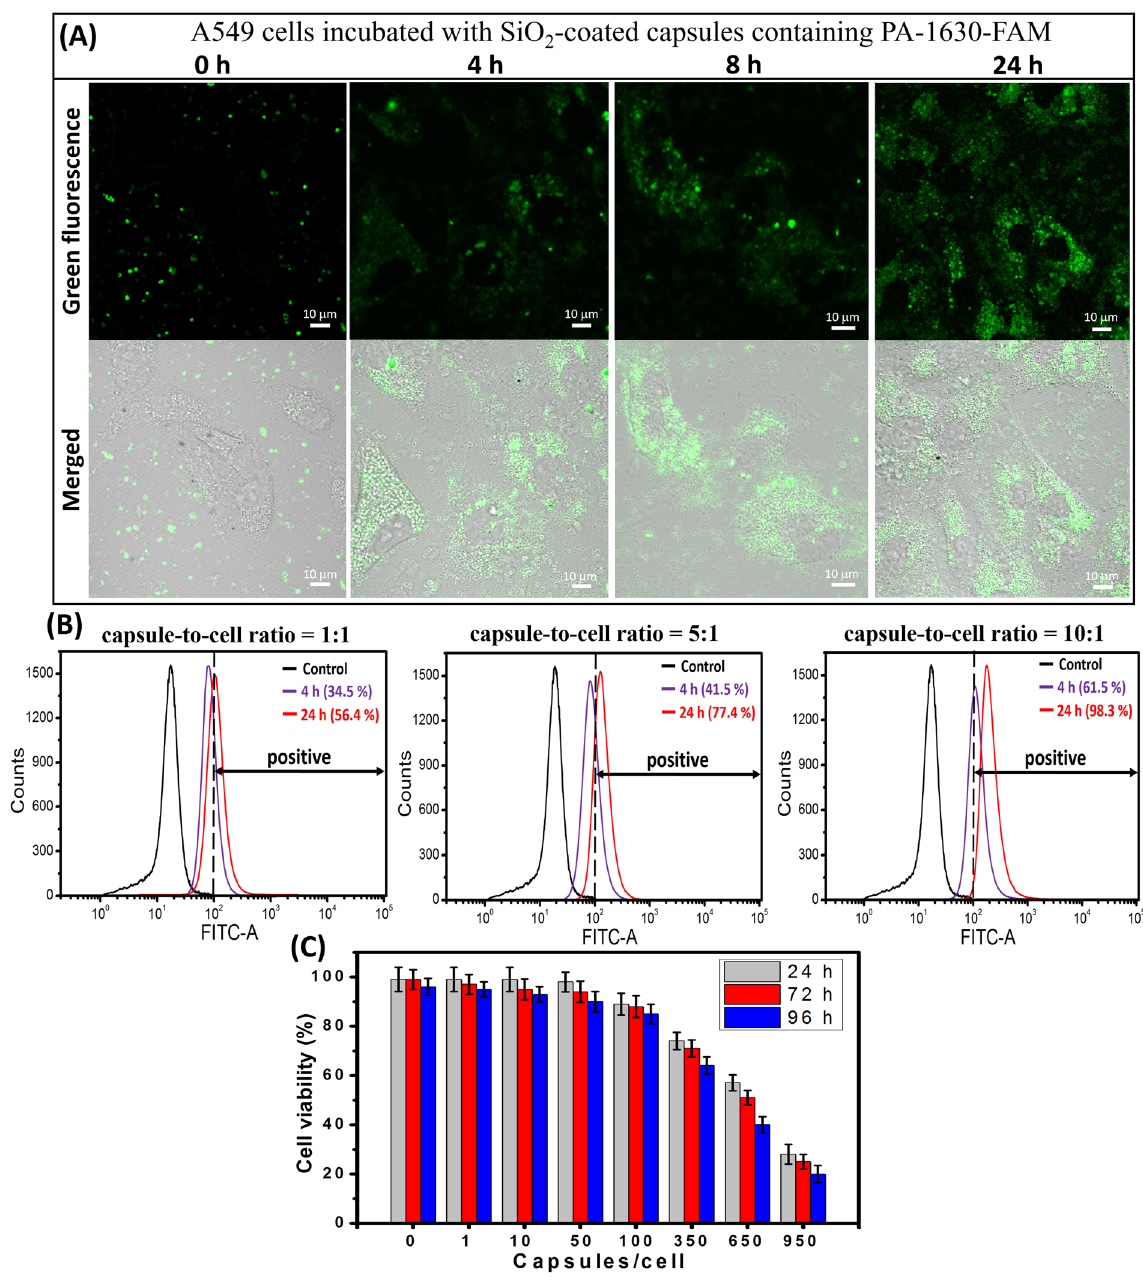
Figure 5. ( A ) CLSM images demonstrating the intracellular release of PA-1630-FAM from SiO 2 -coated capsules and further PA-1630-FAM distribution in A549 cells at different incubation period. ( B ) Flow cytometry analysis of SiO 2 -coated capsules uptake in A549 cells at different capsules-to-cell ratio and incubation time. ( C ) Cell viability of A549 cells incubated with SiO 2 -coated capsules at different capsules-to-cell ratios for various time intervals (24, 48, or 72